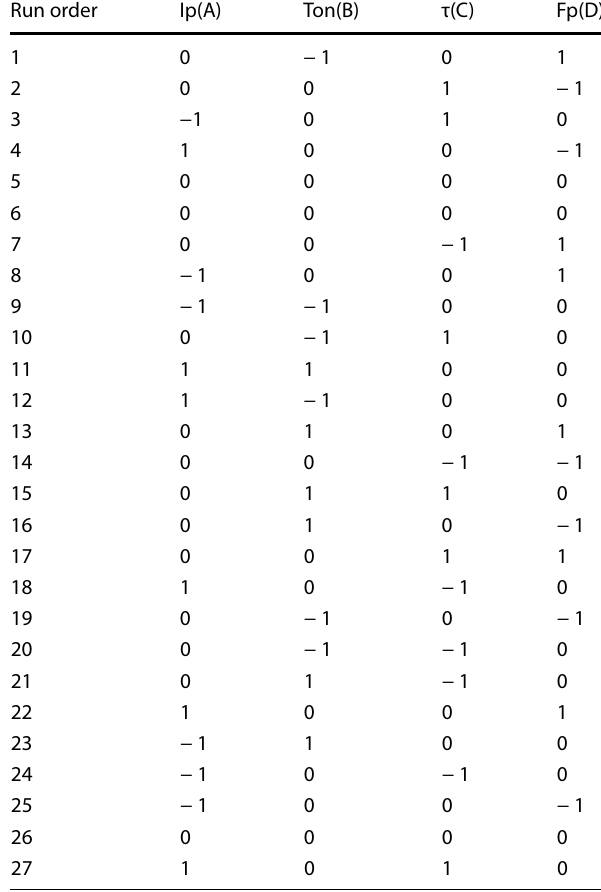
Table 2 Experimental